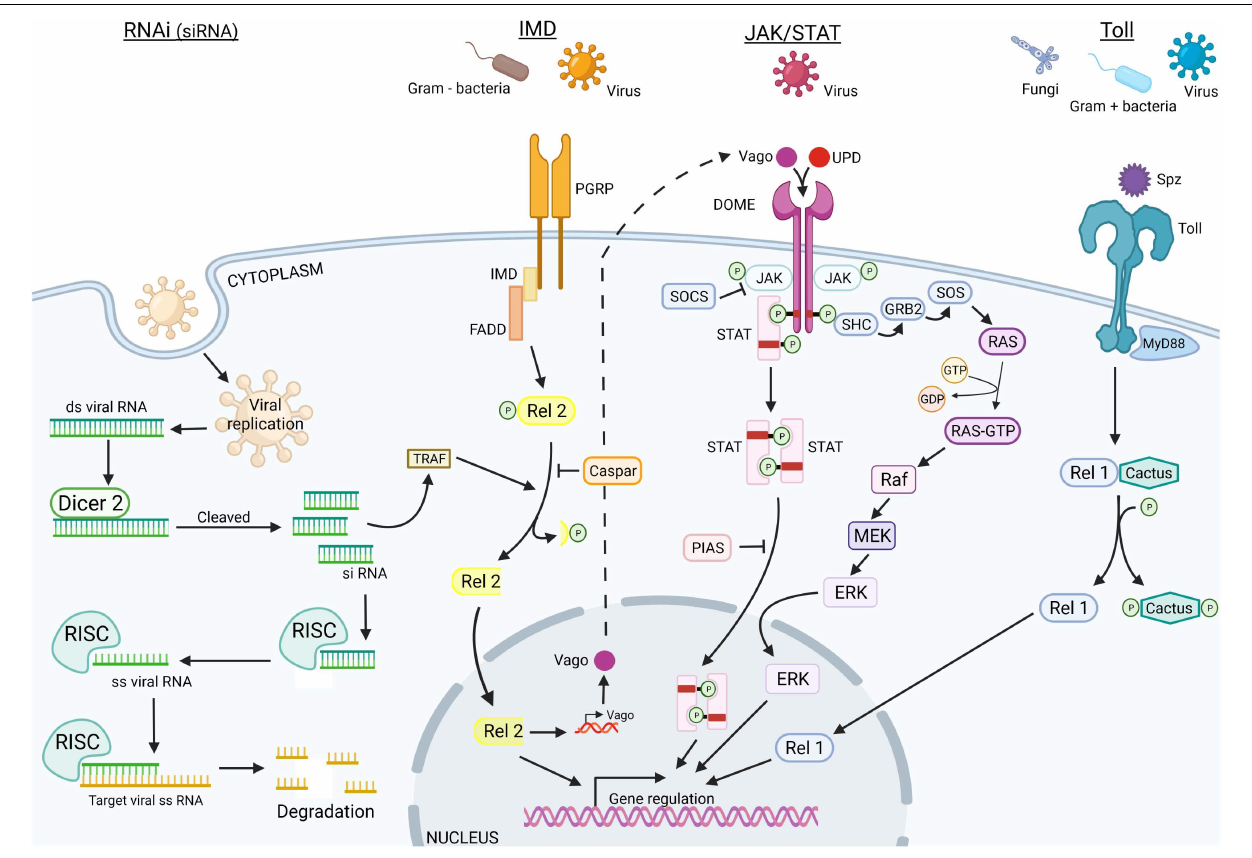
FIGURE 3 | Vector immune pathways to fight against viral infections. The vector immune responses to pathogen infections, composed of four different pathways, allow vectors to neutralize entomopathogens, such as fungi, bacteria, or virus, and are involved in viral infection, replication, dissemination, and transmission along vector life cycle. siRNA (in green), JAK/STAT (in pink), IMD (in orange), and Toll (in blue) immune pathways are represented (Schonhofer et al., 2016; Terradas et al., 2017; Lee et al., 2019). Created with